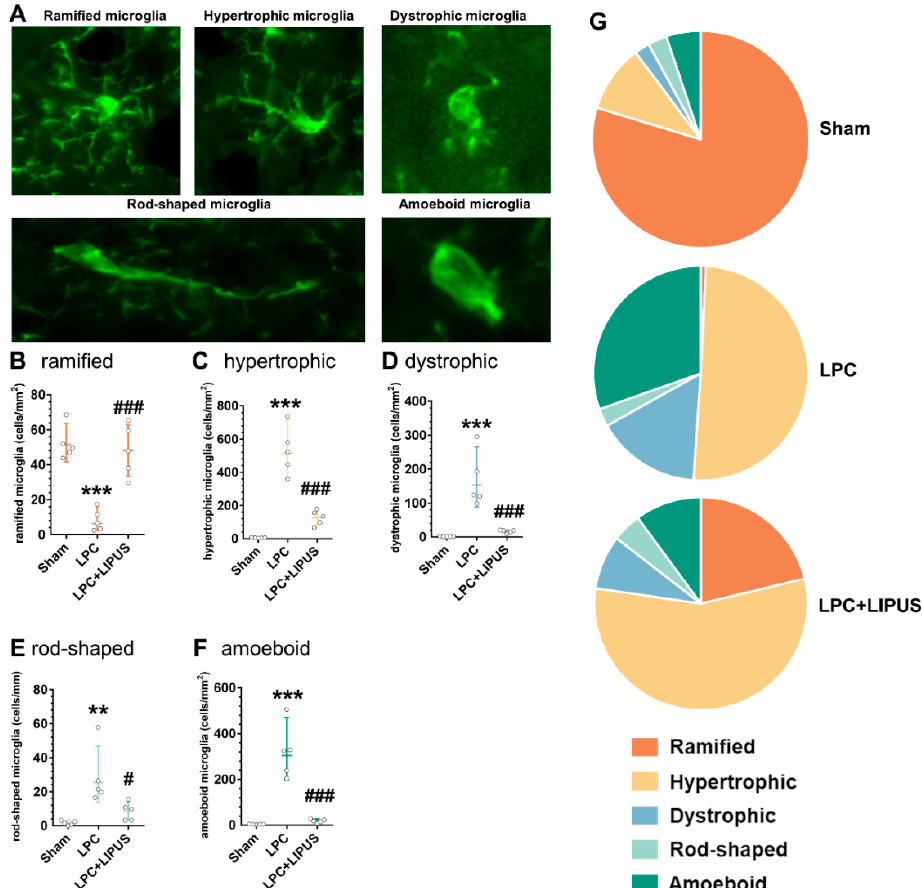
Figure 3. Group-specific patterns in Iba1 + microglial morphologies. ( A ) Five microglial morphologies were analyzed: ramified microglia, hypertrophic microglia, dystrophic microglia, rod-shaped microglia, and amoeboid microglia. Microglial counts are provided for the demyelination lesion in the hippocampus for ( B ) ramified, ( C ) hypertrophic, ( D ) dystrophic, ( E ) rod-shaped, and ( F ) amoeboid morphologies. ( G ) The number of microglia in each of the five distinct classes was plotted as a percentage of the total microglial number for the three groups. The magnification is ×200. # denotes significant differences from the sham and LPC groups, respectively (**, p < 0.01; ***, p < 0.001; # , p < 0.05; ### , p < 0.001, n = 5). LPC: lysolecithin, LIPUS: low-intensity pulsed ultrasound, and Iba1: ionized calcium-binding adaptor molecule 1.